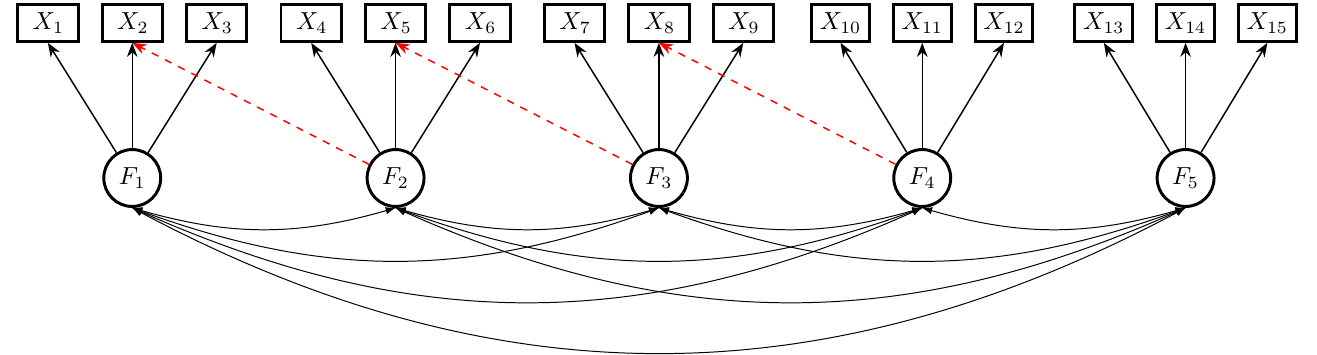
Figure 8. Simulation Study 4: Data-generating model with cross loadings (DGM2). Cross loadings are displayed with dashed red arrows.